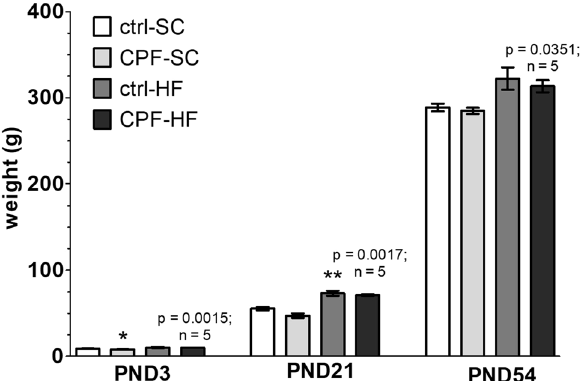
Figure 1. Body weight (g) at birth (PND3) after weaning (PND21) and at young adult age (PND54) of male offspring from CPF and/or HFD exposed mothers. Values are expressed as mean ± SEM (n = 5–20). * , **Significantly different (p < 0.05; p < 0.01) compared with ctrl-SC using the analysis of variance (ANOVA) and a subsequent post hoc Bonferroni test. ctrl control, CPF Chlorpyrifos, HF high fat, SC standard chow, PND postnatal day.